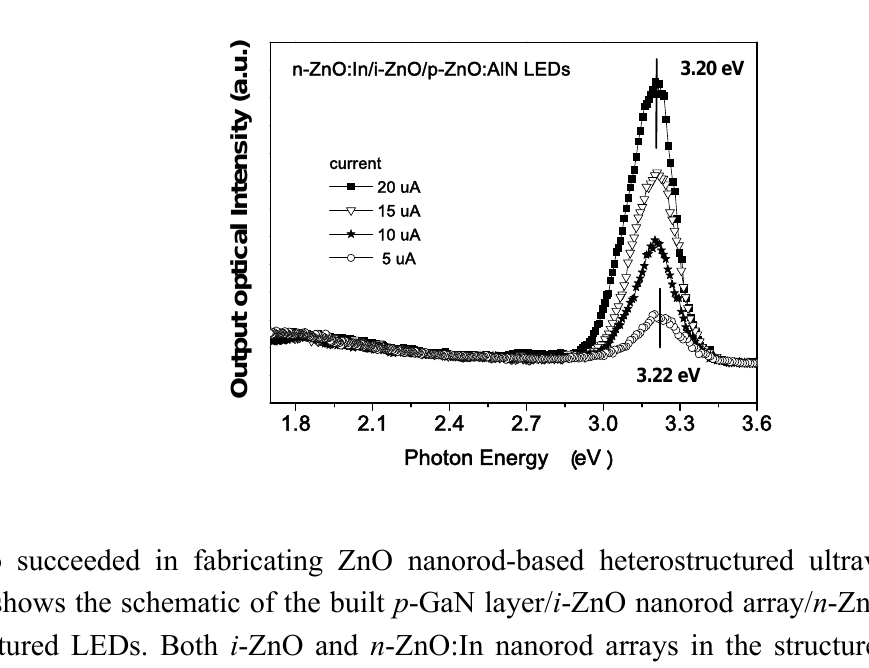
Figure 23. Room-temperature electroluminescence (EL) spectra of the p-i-n ZnO-based LEDs under different operation currents. Reprinted from Ref. [158] with